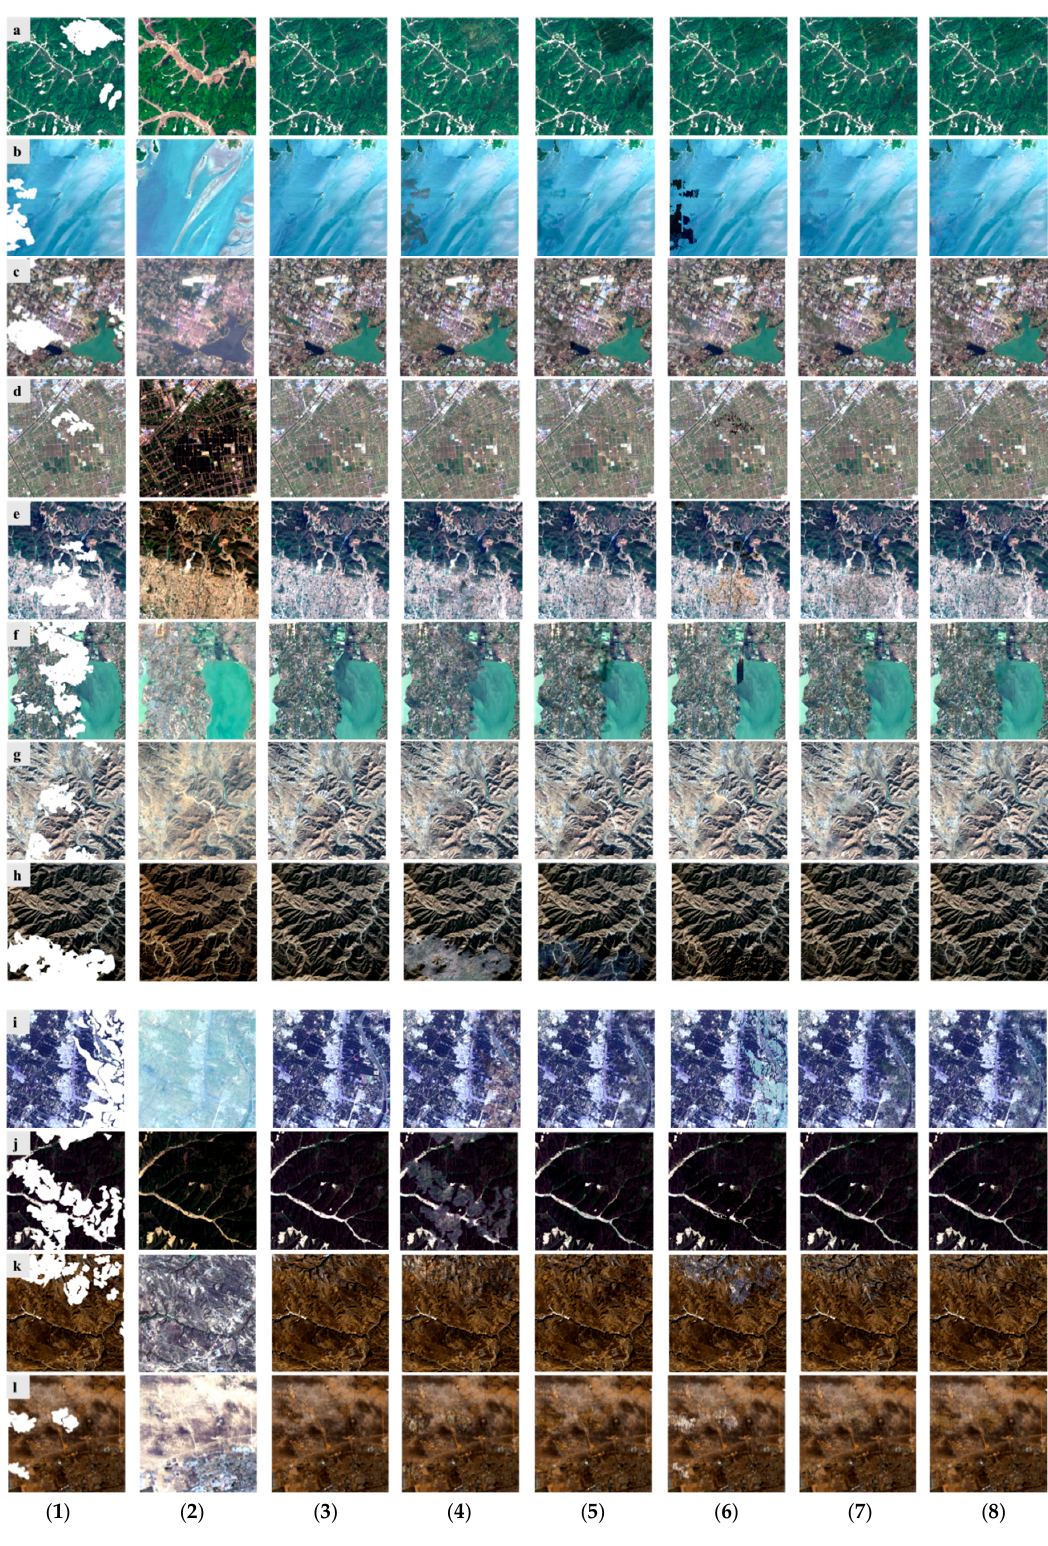
Figure 5. Comparison of cloud removal results predicted from different methods in different scenes